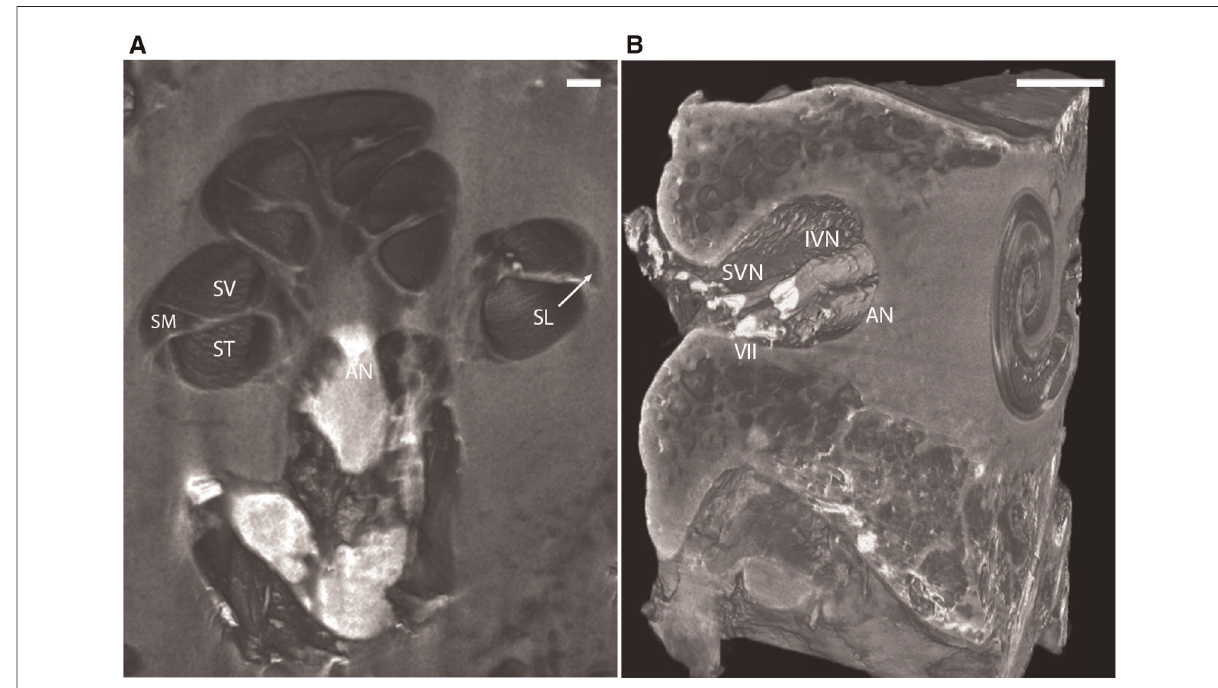
FIGURE 3 ( A ) Mid-modiolar 3D virtual cross-section through the human cochlea in I 2 KI stained bone. Boundaries between scala tympani (ST), scala vestibuli (SV), and scala media (SM) are appreciated. Spiral ligament (SL) is well de fi ned, and auditory nerve trunk is seen. Scale=1 mm. ( B ) 3D reconstruction of I 2 KI stained temporal bone. Anatomical relationship between the cochlea and the structures of the internal auditory meatus including facial nerve (VII), auditory nerve (AN), superior vestibular nerve (SVN) and inferior vestibular nerve (IVN) are seen. I 2 KI, Lugol ’ s iodine solution. Scale=0.5